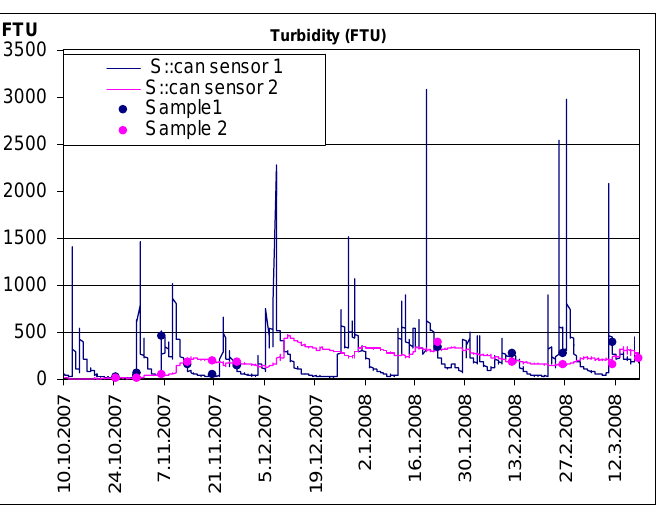
Figure 9. Turbidity samples (dots) and turbidity measured by spectrometer (solid line) from the constructed wetland of